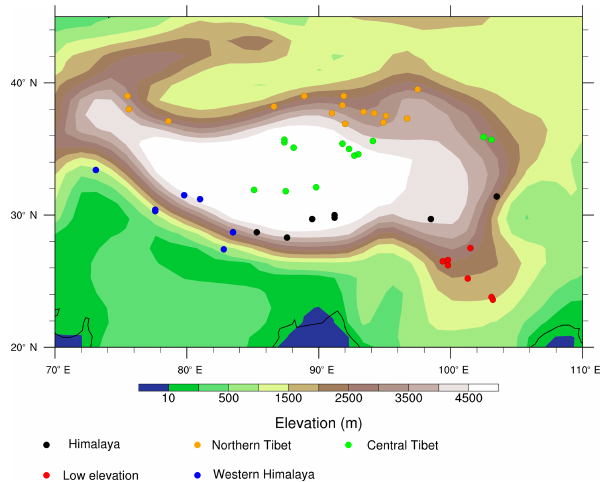
Figure 16. Map of δ 18 O p paleoaltimetry sites (filled circles) plotted on surface elevation (shaded). Sites are classified by their type (see Sect. 4.2 for more details on the categories and Table S1 for a list of the